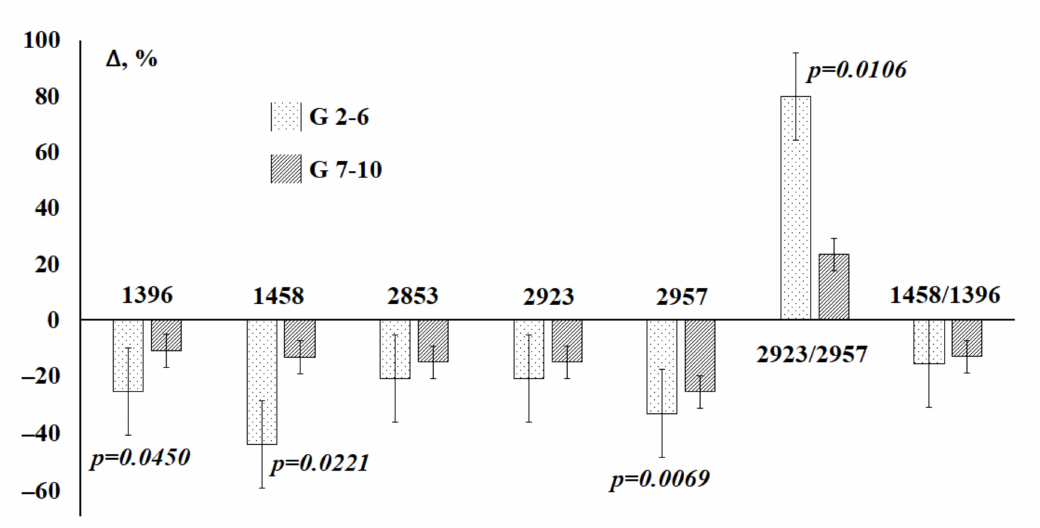
Figure 9. Changes in the intensity of lipid absorption bands in saliva in prostate cancer depending on Gleason grade compared to healthy controls. p -values are calculated using the paired Mann–Whitney